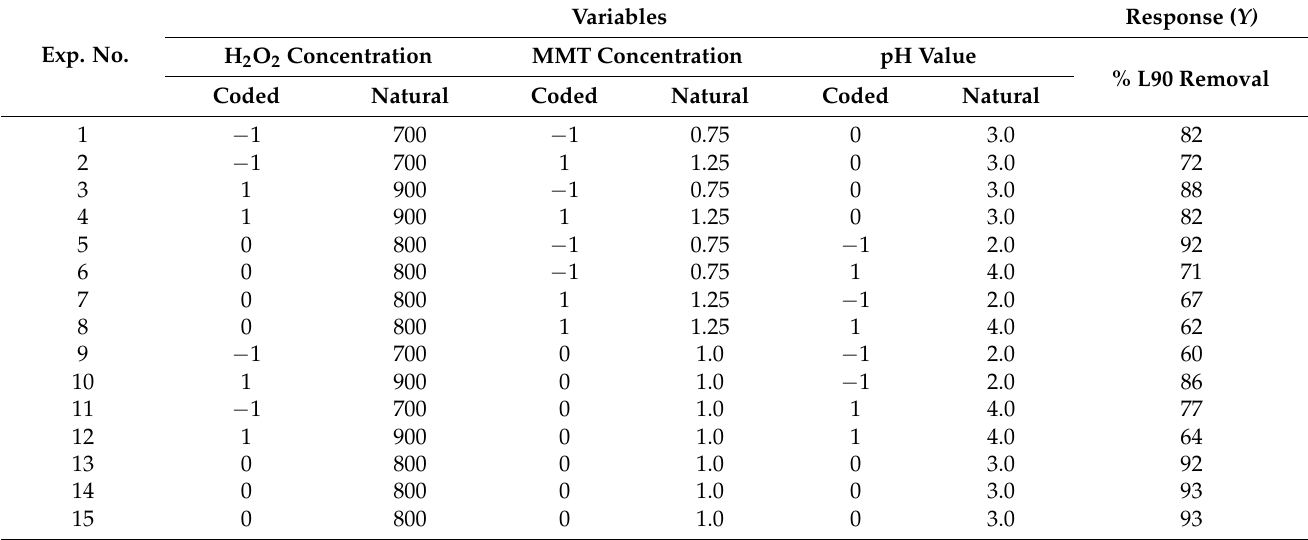
Table 3. Box–Behnken factorial design in terms of coded and natural variables and the corresponding Lanox 90 removal rate affecting effluent